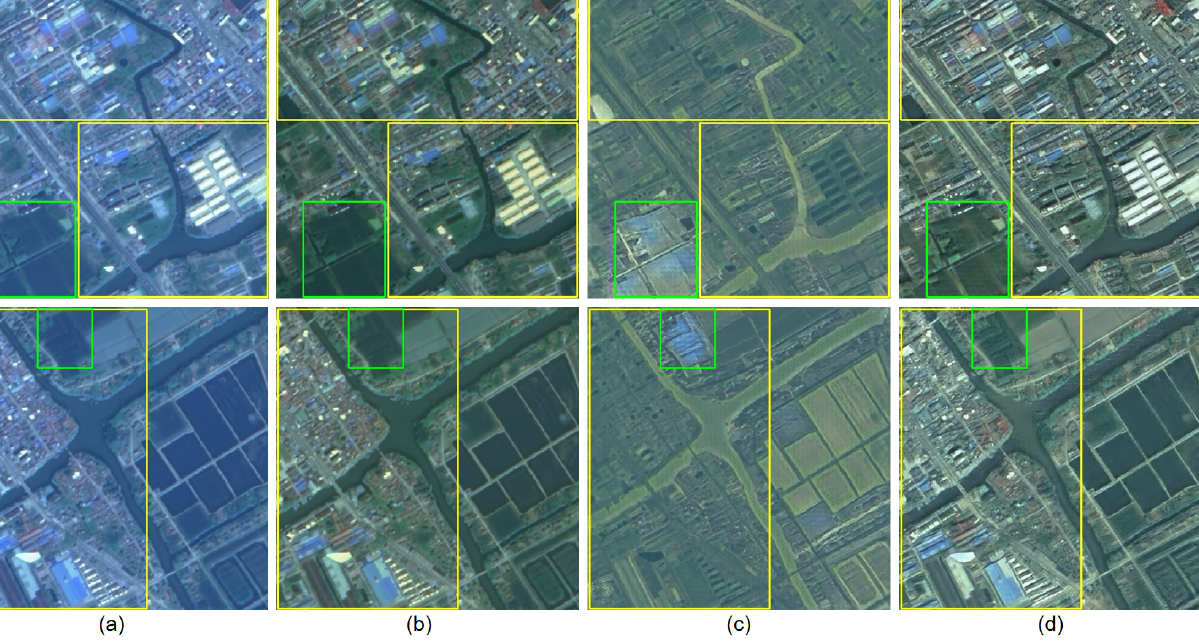
Figure 14. GF-1B to GF-1: Original GF-1B images and the transformed images which are used to train the classifier for GF-1 images. ( a ) GF-1B images. ( b ) Color matching. ( c ) CycleGAN. ( d ) BiFDANet